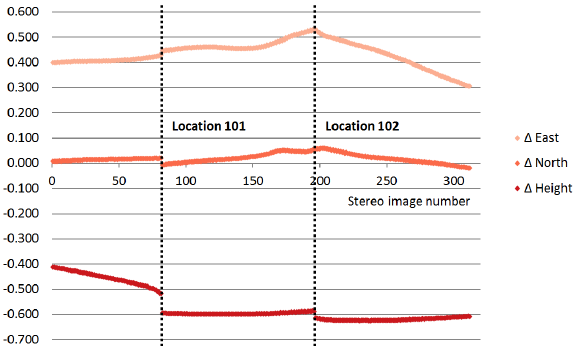
Figure 8. Deviations of projection centers in m for sequence 1.2